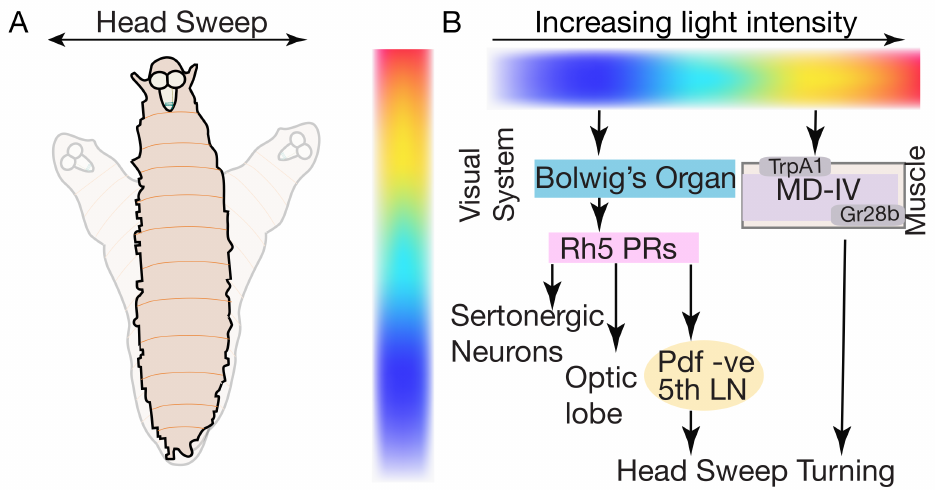
Figure 8. Schematics of neural circuit involved in phototaxis behavior. ( A ) Larval schematic show- ing head sweep behavior ( B ) Neural circuit showing phototaxis pathway, which mediate head sweep or turning behavior in response to low and intense light, respectively (adapted and modi- fied from